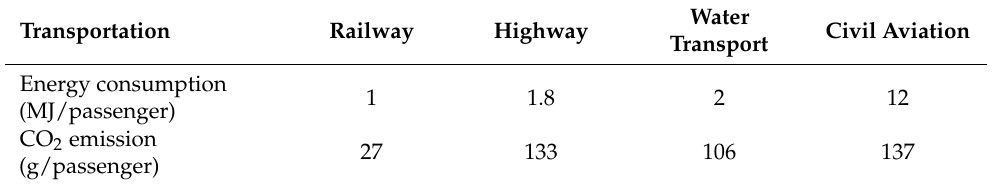
Table 1. Energy consumption and carbon emissions of tourism-related transport.